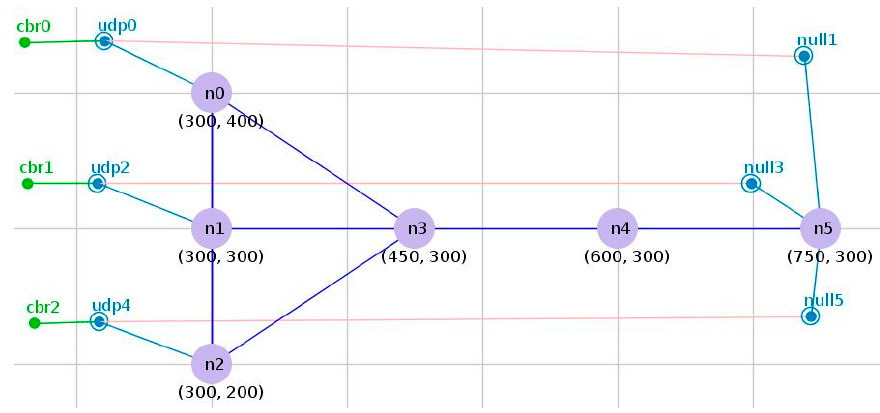
Figure 1. Simple tree topology.